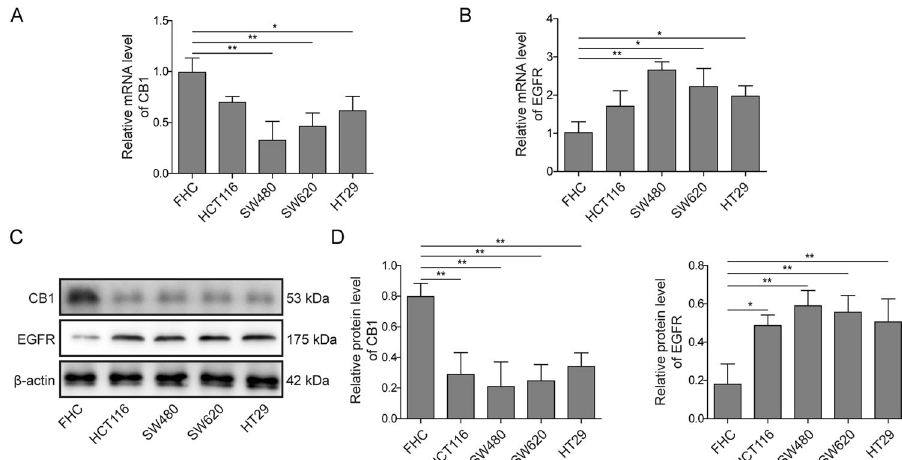
Fig. 1 Expression of CB1 and EGFR in normal colon cells and colorectal cancer cells. A QPCR results showed that CB1 was downregulated in colorectal cancer cells. B QPCR results showed that EGFR was upregulated in colorectal cancer cells. C, D Western blot analysis showed that CB1 was downregulated and EGFR was upregulated in colorectal cancer cells. * P < 0.05; ** P <